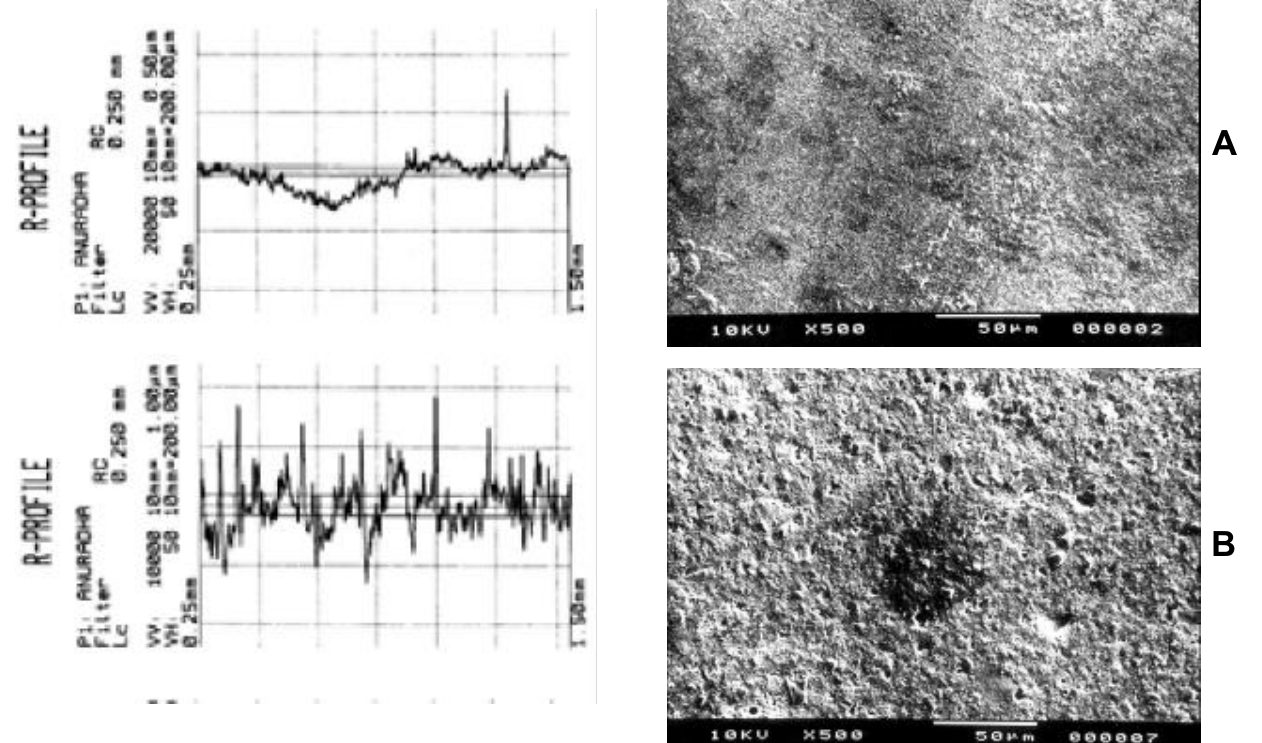
FIGURE 2 - Roughness and microscopic evaluation of Rely X (3M) resin cement before (a) and after (b) brushing